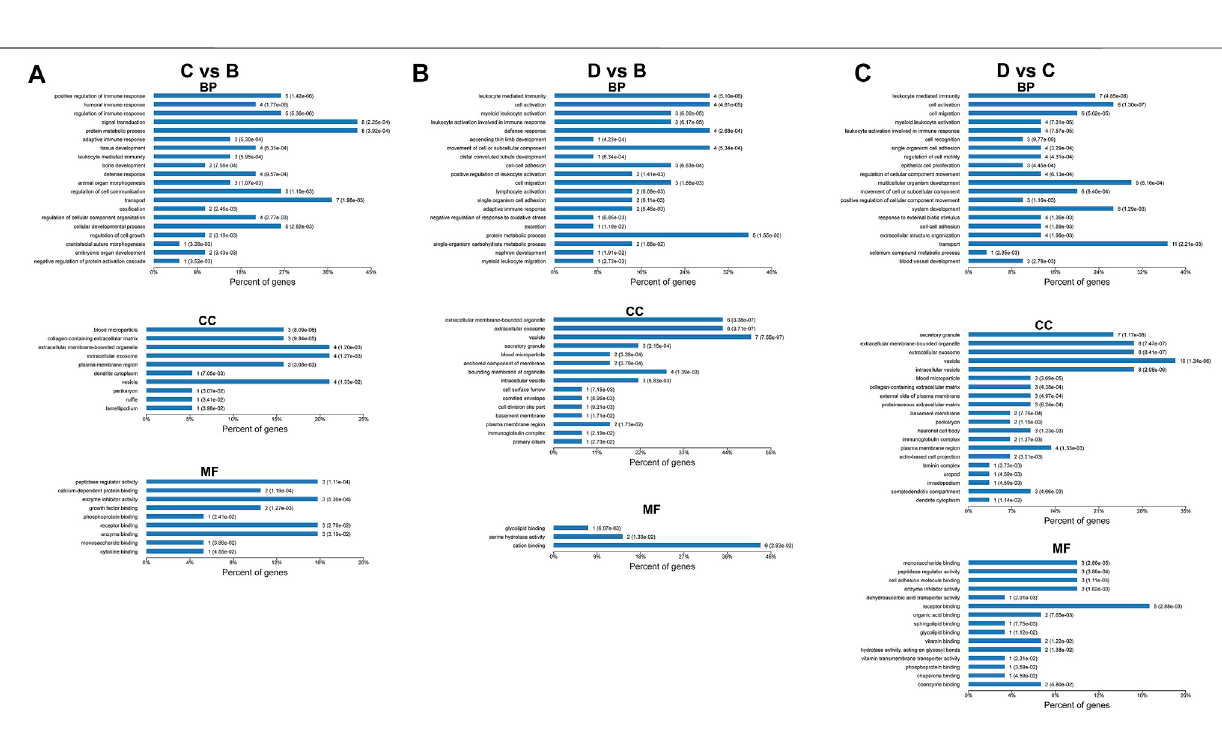
Frontiers in Molecular Biosciences |